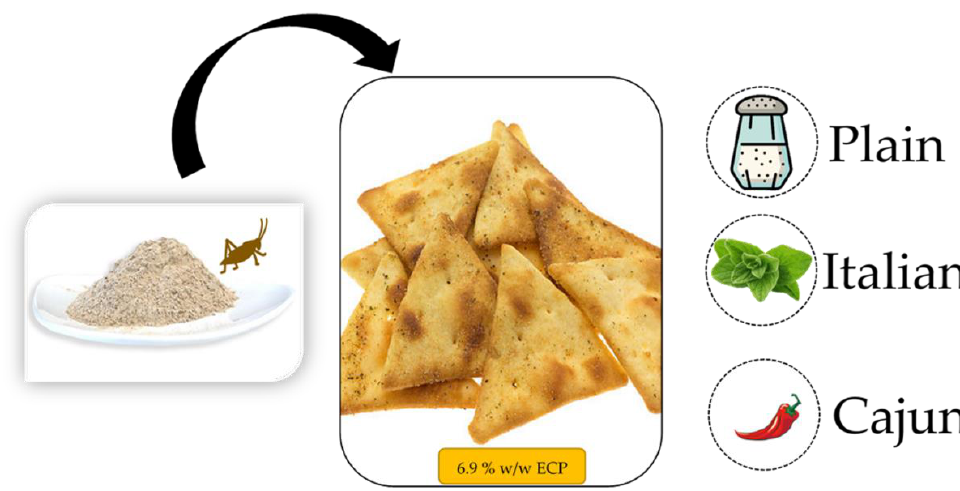
Figure 1. Graphical description of treatments (plain, Italian, and Cajun pita chip formulations containing 6.9 % w/w ECP). ECP = Edible cricket protein.